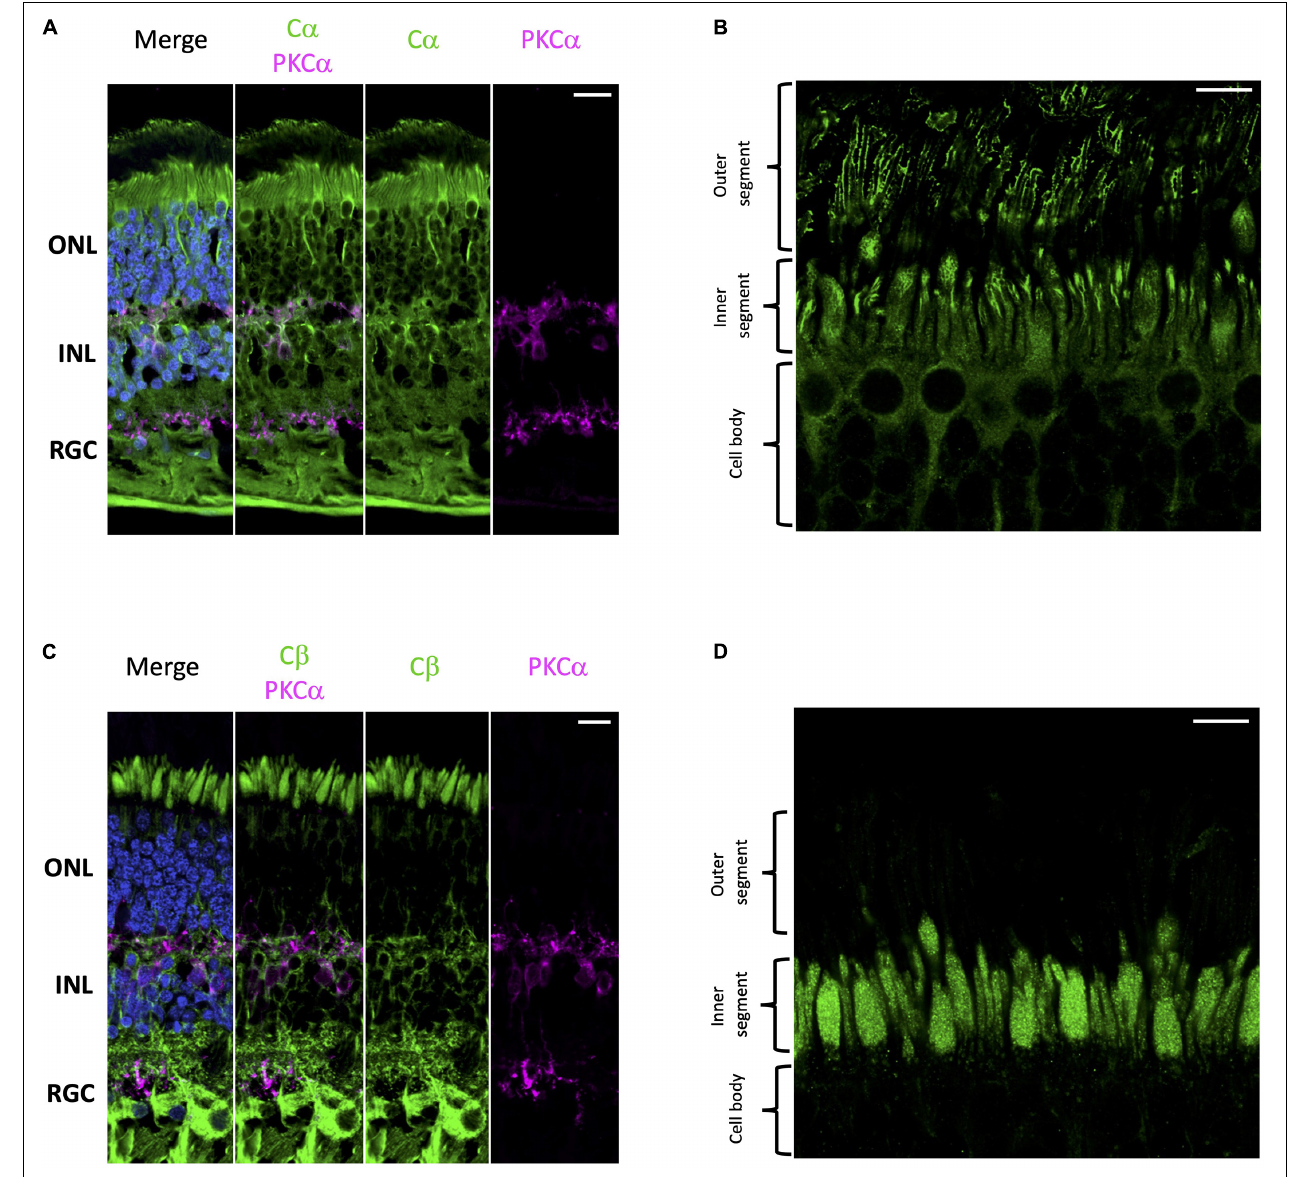
FIGURE 2 | C α and C β are differentially localized in human retina. (A–D) All sections were labeled with anti-PKC α antibodies in order to identify rod-bipolar cells (purple), which helped distinguish between the outer nuclear layer (ONL), inner nuclear layer (INL), and retinal ganglion cell layer (RGC). Nuclei in blue, scale bar = 20 µ m (A,C) , 10 µ m (B,D) . (A) C α (green) is localized to cells in the ONL, INL, and RGC. (B) In photoreceptors, C α is generally localized to the cell body of both cone and rod photoreceptor cells; however, there is increased signal at the junction between the inner and outer segment. (C) C β (green) is localized to cells in the ONL, INL, and RGC. (D) In photoreceptors, C β (green) was limited to the ellipsoid of the inner segment, and notably absent from the outer segment and the junction connecting the inner and outer